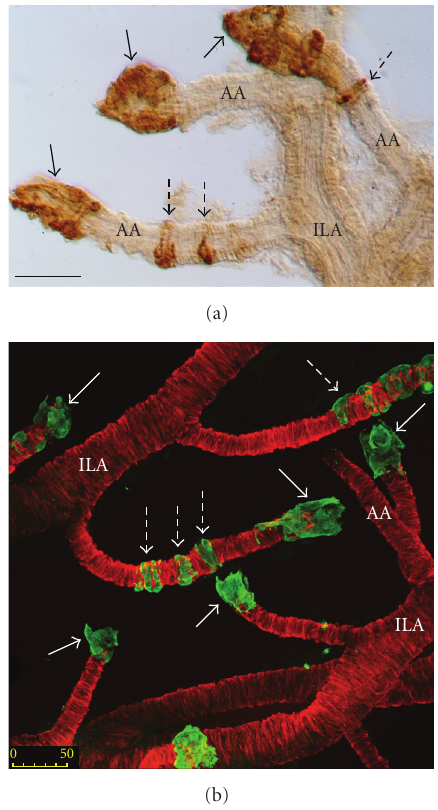
Figure 2: Portions of the renal preglomerular vasculature com- prised of an interlobular artery (ILA) and a ff erent arterioles (AA) were isolated after HCl hydrolysis in rats chronically treated with captopril (see legend to Figure 1). Renin cells are localized to the AA tip (single arrows); captopril treatment also recruits renin cells upstream (dashed arrows). (a) Single labeling against renin (see Figure 1 legend) with ABC peroxidase kit (brown label, Vector Laboratories, Burlingame, CA). Recruited renin cells are spindle- shaped as smooth muscle cells, whereas renin cells at the tip of AA adopt a more globular shape. (b ) Double labeling against renin (green label, fluorescein isothiocyanate-labeled secondary anti body) and against α -SM actin (red label, tetramethylrhodamine- labeled secondary antibody); for primary antibodies see legend to Figure 1. The image was generated as previously detailed [86] using a confocal microscope (Biorad MRC1024, Bio-Rad Life Science Research, Hercules, CA) by projecting 52 serial optical sections. Bars: 50 μ